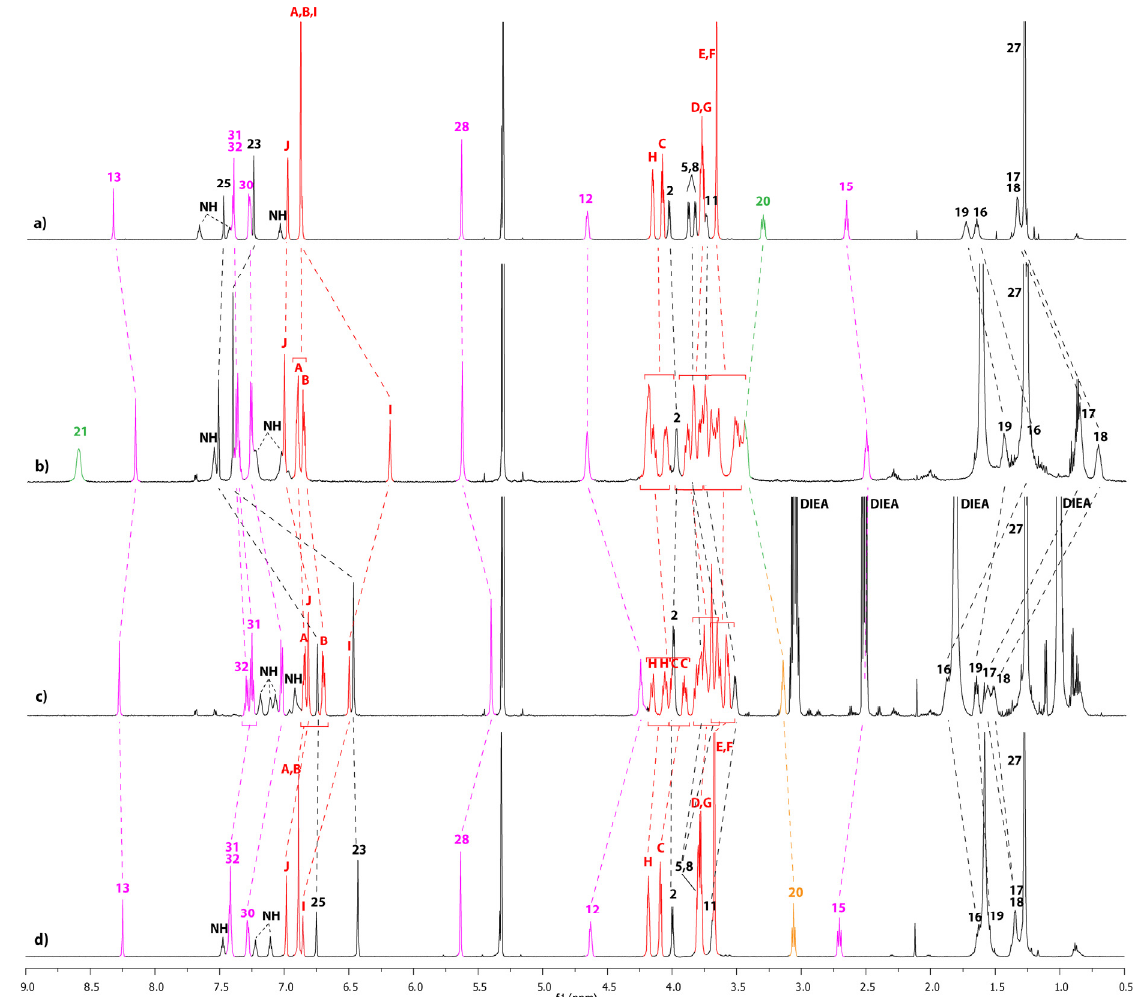
Figure 5. 1 H-NMR spectra (600 MHz, CD Cl , 298 K) of: ( a ) the protonated unthreaded 2 2 compound 13u . ( b ) the protonated lasso-based compound 13 . ( c ) the deprotonated lasso- based compound 14 . ( d ) the deprotonated unthreaded compound 14u . The coloring, lettering and numbering correspond to the proton assignments indicated in scheme